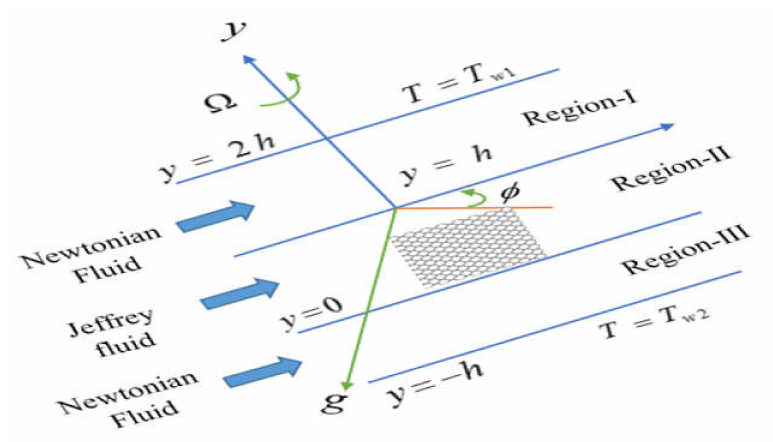
Figure 1. Physical